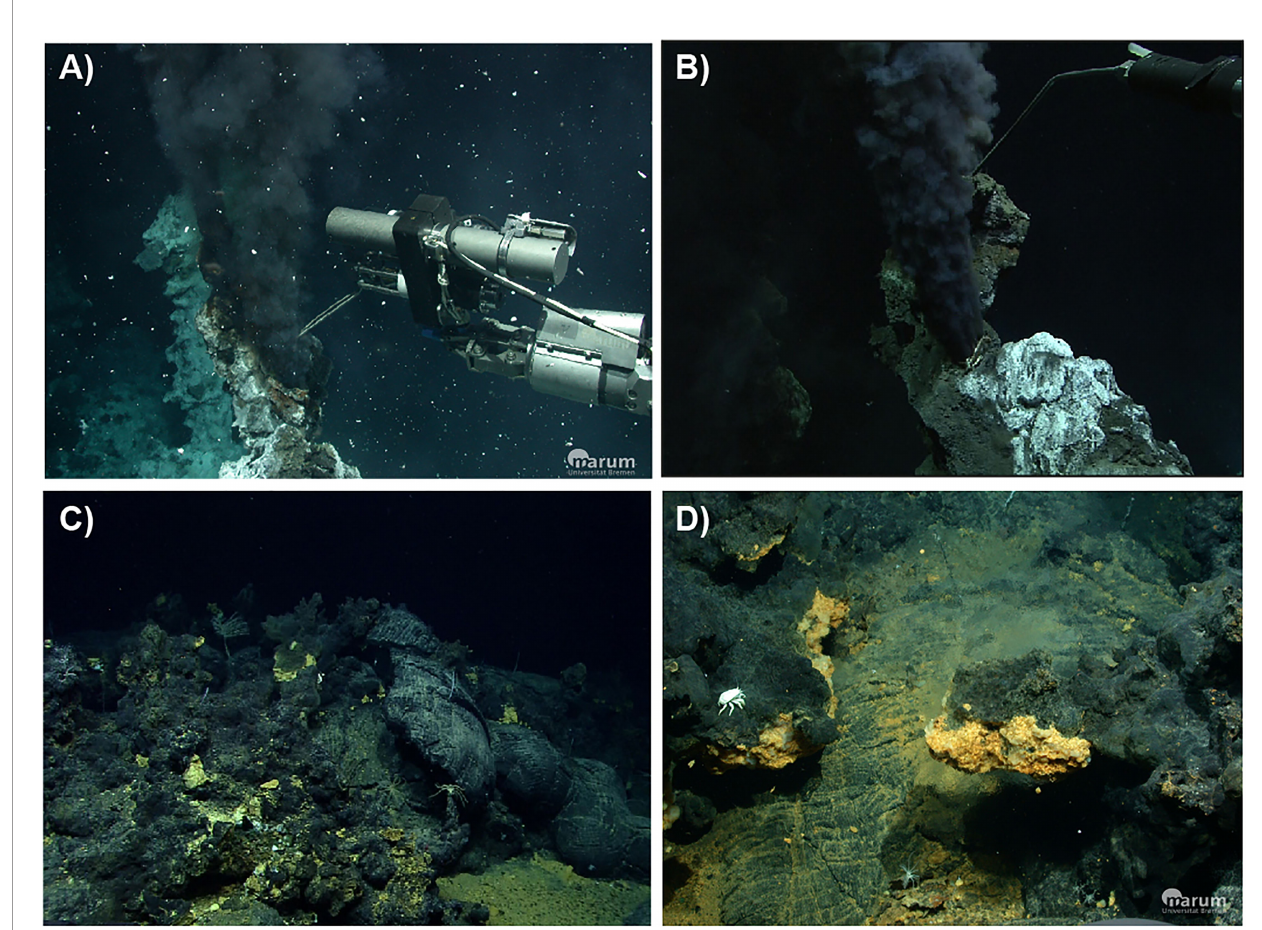
FIGURE 3 | Images of hydrothermal ori fi ces at E2: (A) Iced Bun chimney; (B) Dog ’ s Head Chimney; (C) Diffuse fl ows escaping from pillow basalts at E2-W (D) E2-W tube